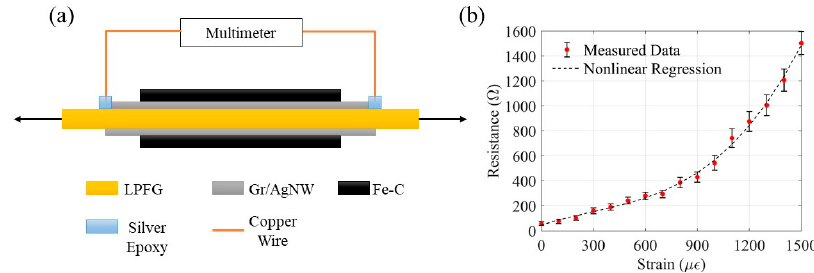
Figure 7. Sensor resistance measurement under various strain levels: ( a ) test setup, and ( b ) results.